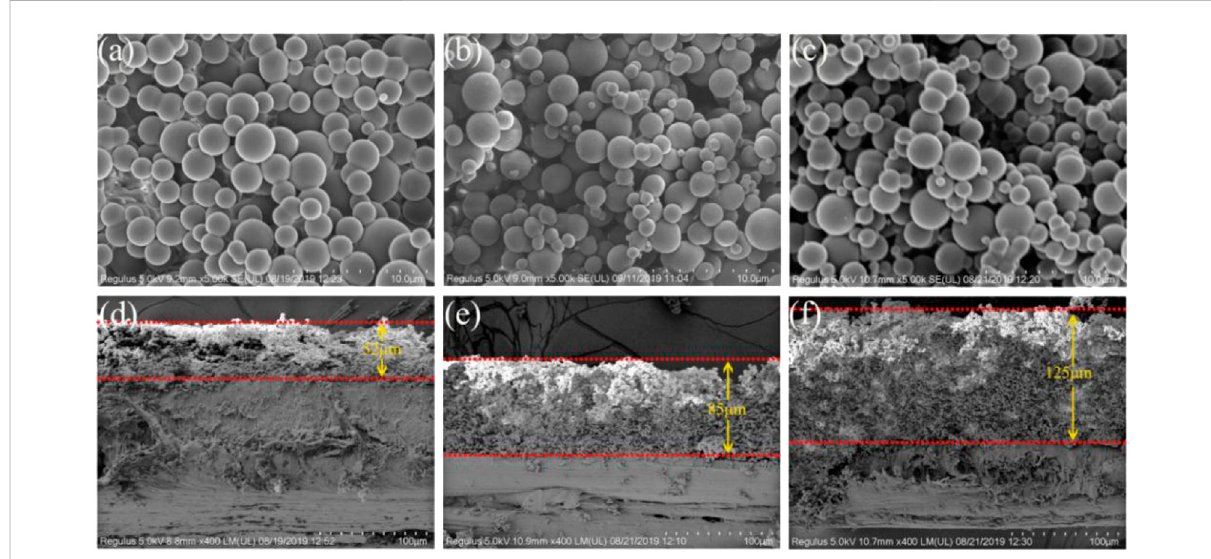
FIGURE 4 SEM images of h5.0d15-z: (A) , (D) h5.0d15-10; (B) , (E) h5.0d15-20; (C) , (F) h5.0d15-30.